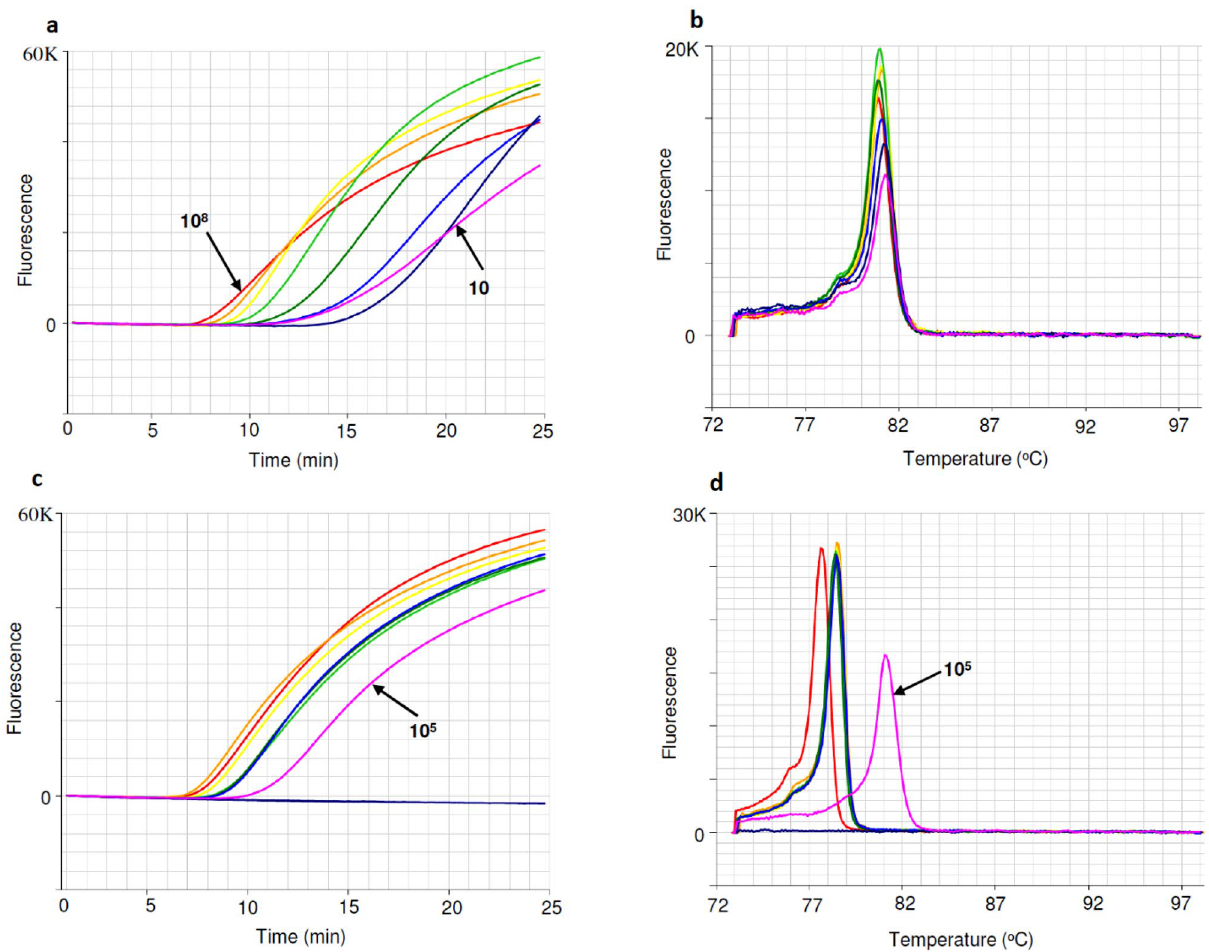
ten-fold dilution. ( b ) Anneal derivative of gBlock LAMP amplicons, with an anneal derivative of 81 °C. ( c ) Amplification profile of four-fold dilution of FAW DNA (VAITC 10726) and gBlock DNA (10 5 copies, pink). ( d ) Anneal derivative of LAMP amplicons showing two peaks, 78.5 °C for FAW DNA dilutions and 81 °C for gBlock DNA